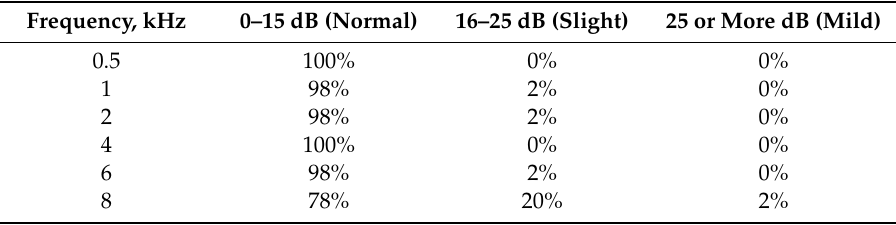
Table 5. Prevalence of hearing threshold shifts, right